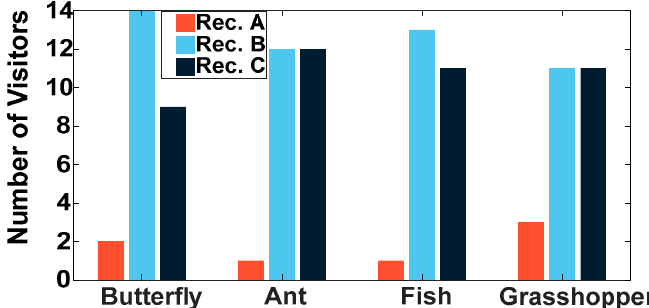
Figure 5. Distribution of the visitors for the recommendations for all the visiting styles.